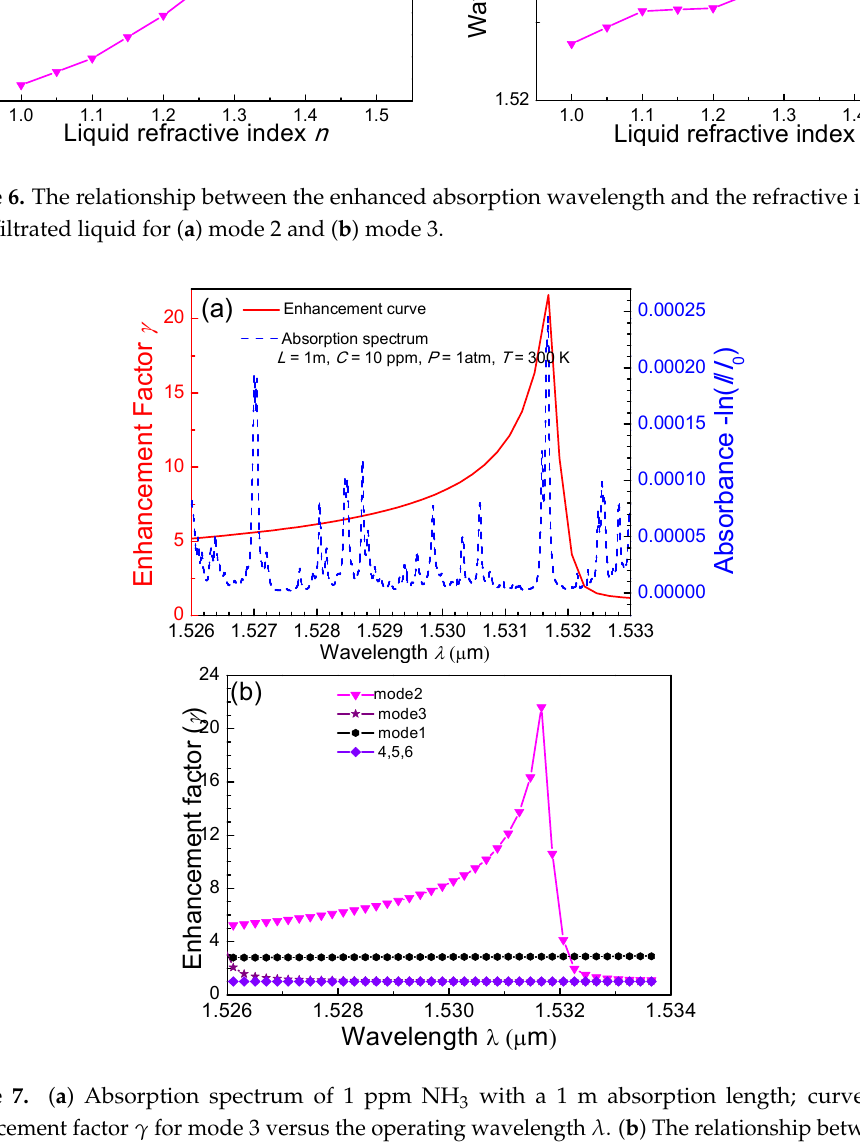
Figure 7. ( a ) Absorption spectrum of 1 ppm NH 3 with a 1 m absorption length; curve of the enhancement factor γ for mode 3 versus the operating wavelength λ . ( b ) The relationship between the absorption wavelength of NH 3 and the enhancement factor for modes 1−6.